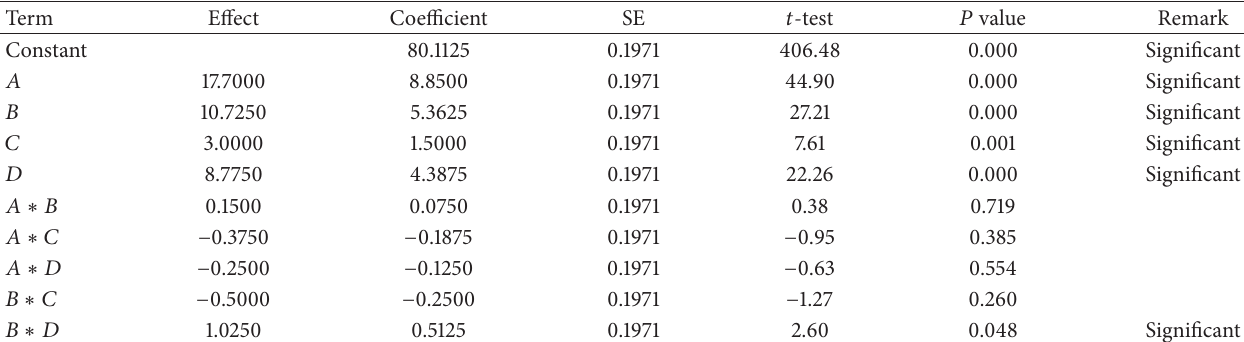
Table 4: Estimated effects and coefficients for 𝑅 % (coded units).